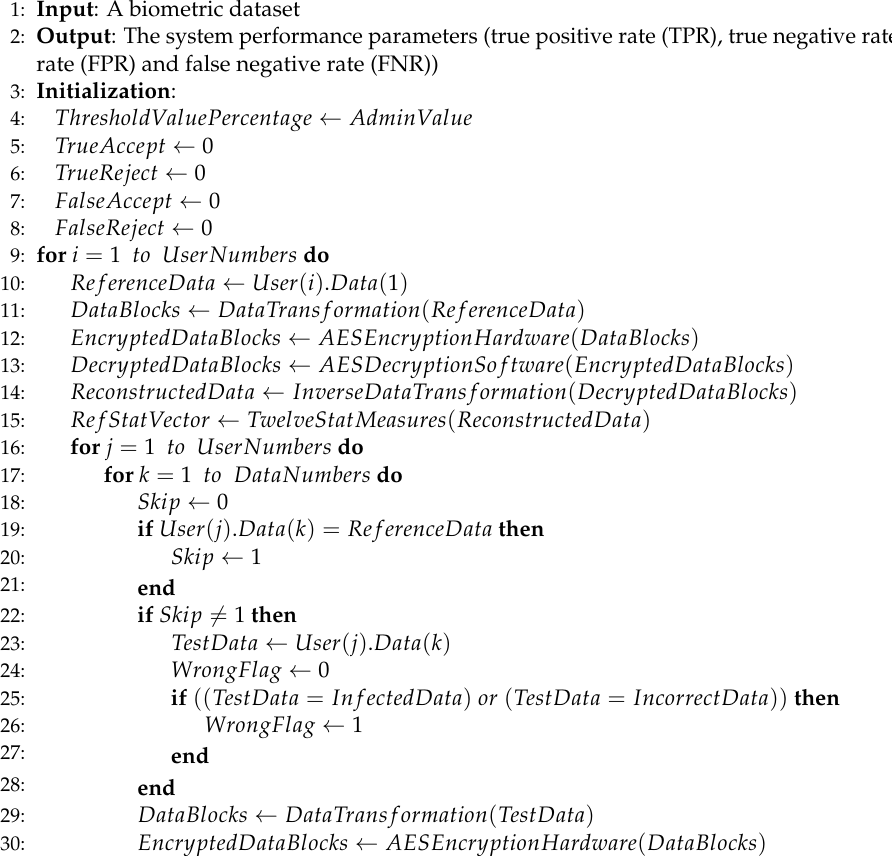
Algorithm 1 The flow of the cross-layer biometric recognition